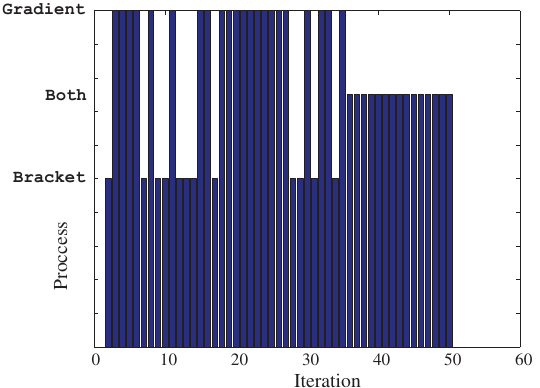
Fig. 11. Process originating the value returned by Compare at each